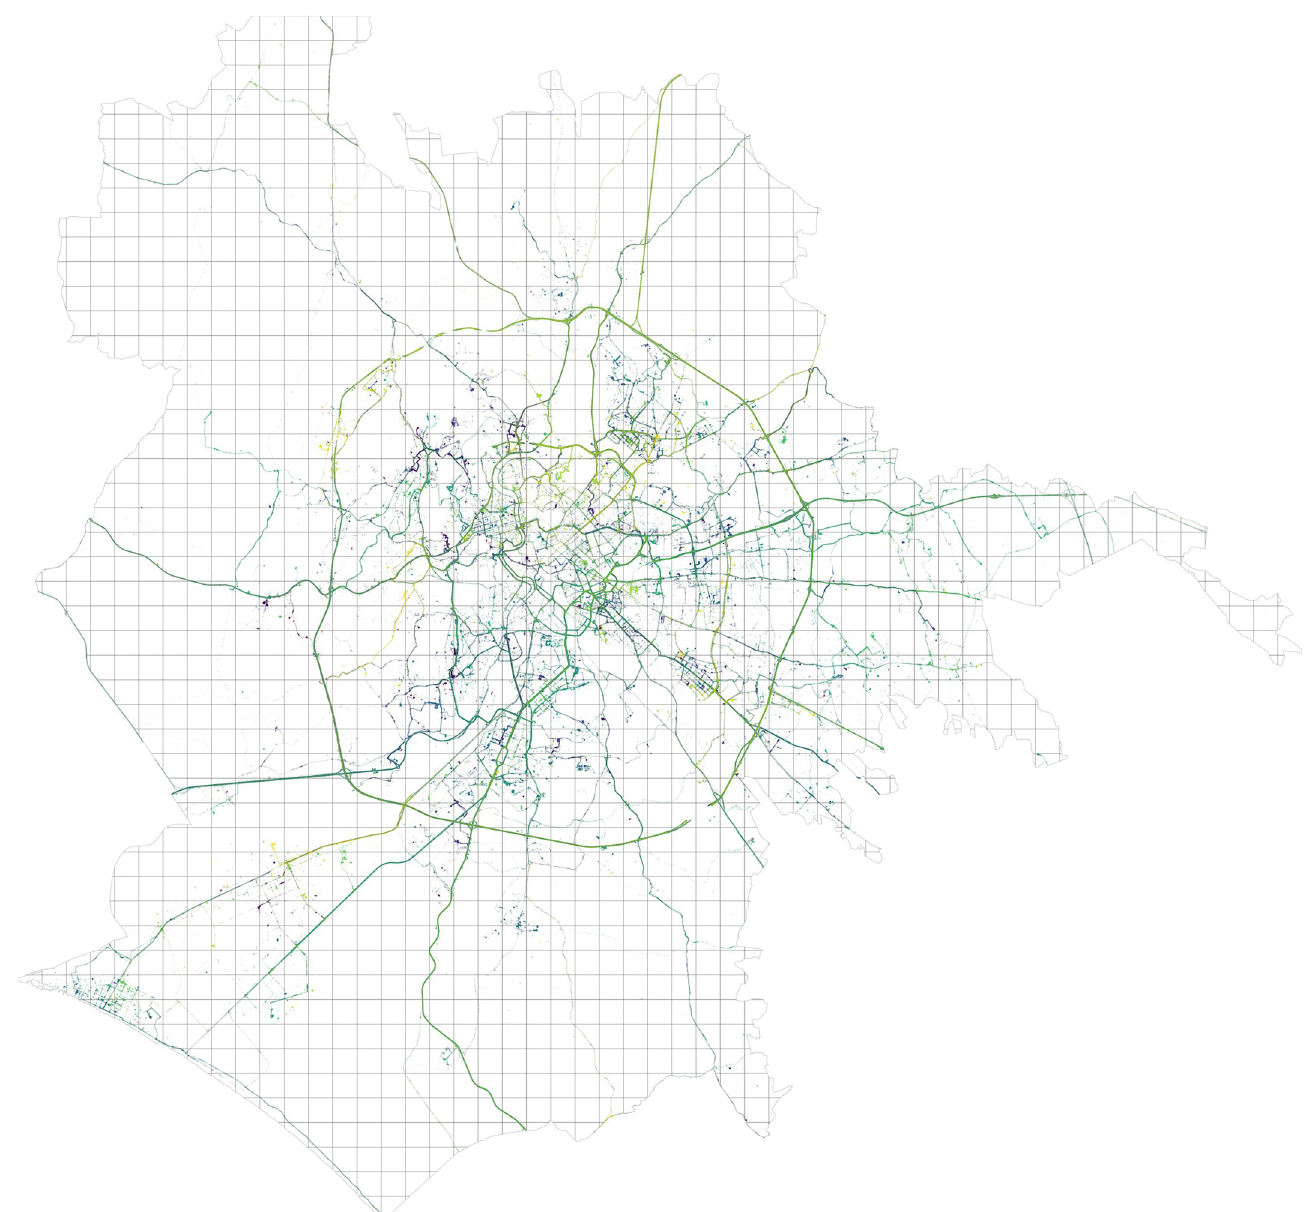
Fig 1. Car GPS trajectories over 1 × 1 km cells in